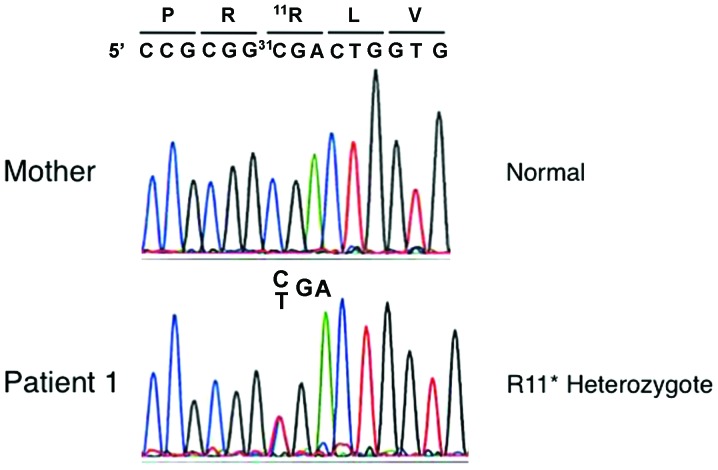
Sequence analysis of patient 1 and her mother. The c.31C>T (p. R11*) mutation site is shown.